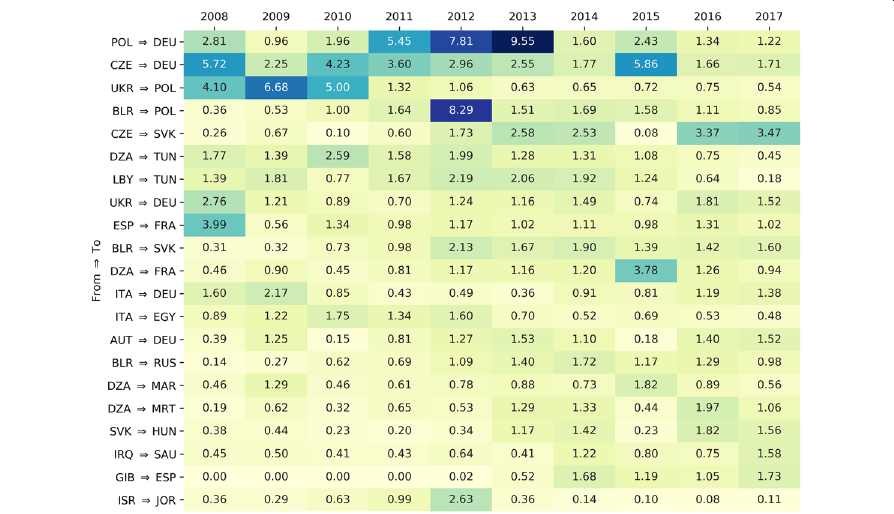
Fig. 8 Main estimated cross-border illicit cigarette flows (billion sticks), 2008 – 2017. Notes: the figure reports the alpha3 ISO code identifying all links that ranked among the top 5 cross-border illicit flows in any year included in the analysis. The links are in a decreasing order, the first one being the link with the highest average illicit flows over the period 2008 –